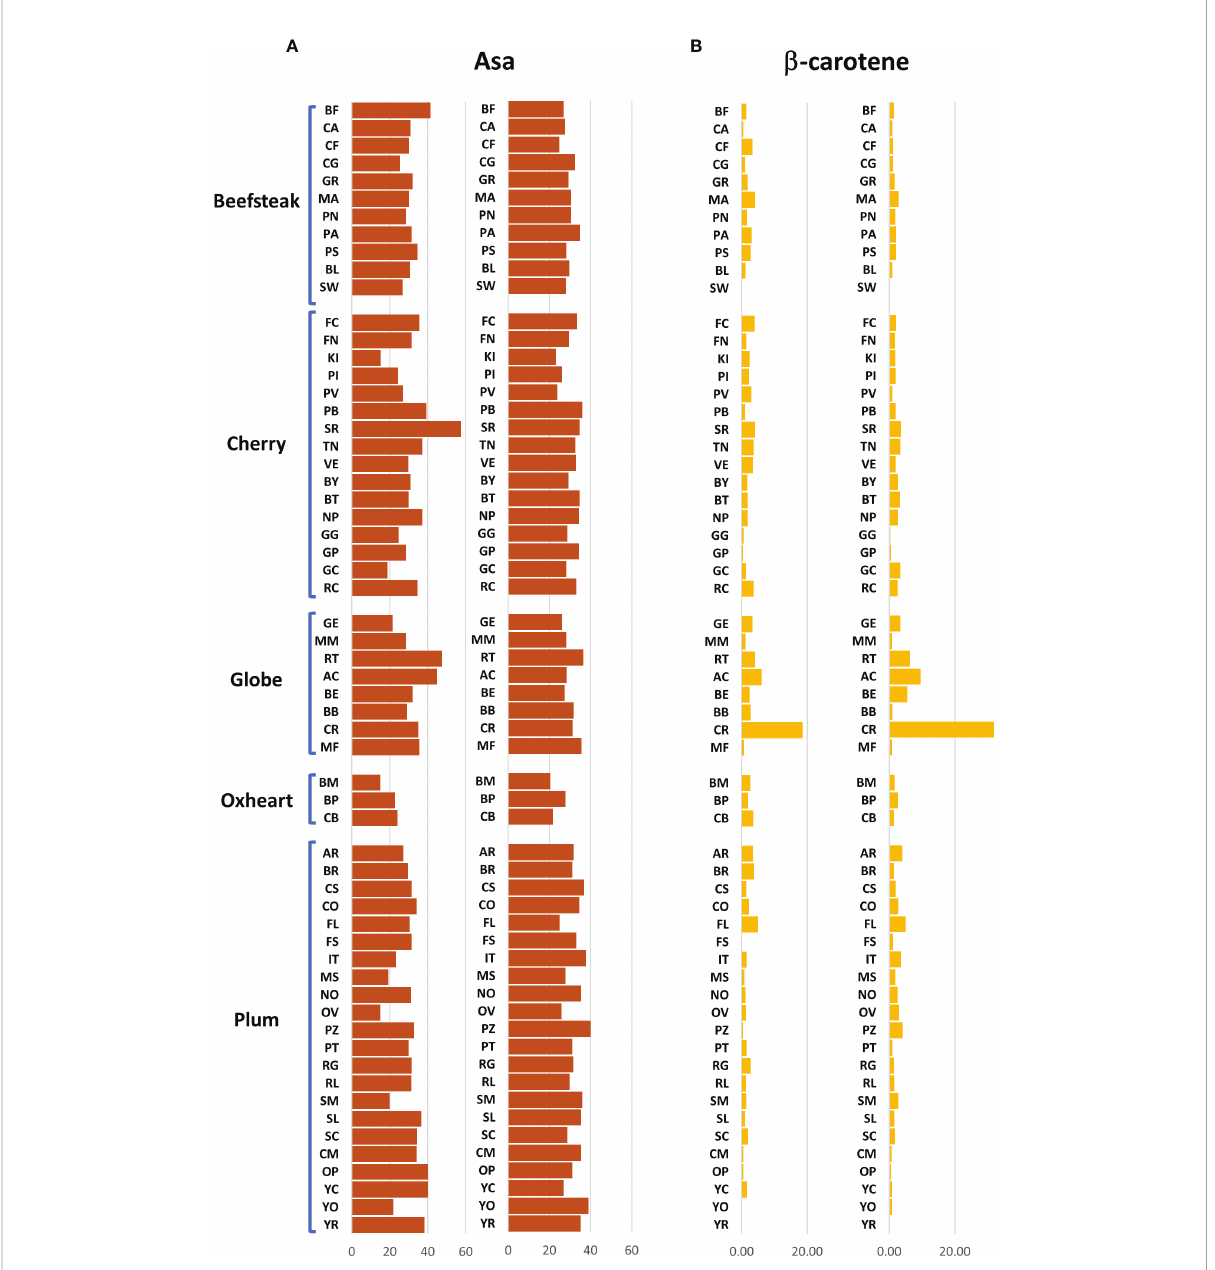
FIGURE 2 Variation for ascorbic acid and b -carotene in 60 heirloom genotypes in the two years of evaluation. Vertical bars show the average values for each accession. For each trait, data of the fi rst and the second seasons are on the left and the right, respectively. Genotypes are ordered based on cultivar group. Acronyms are listed in Supplementary Table